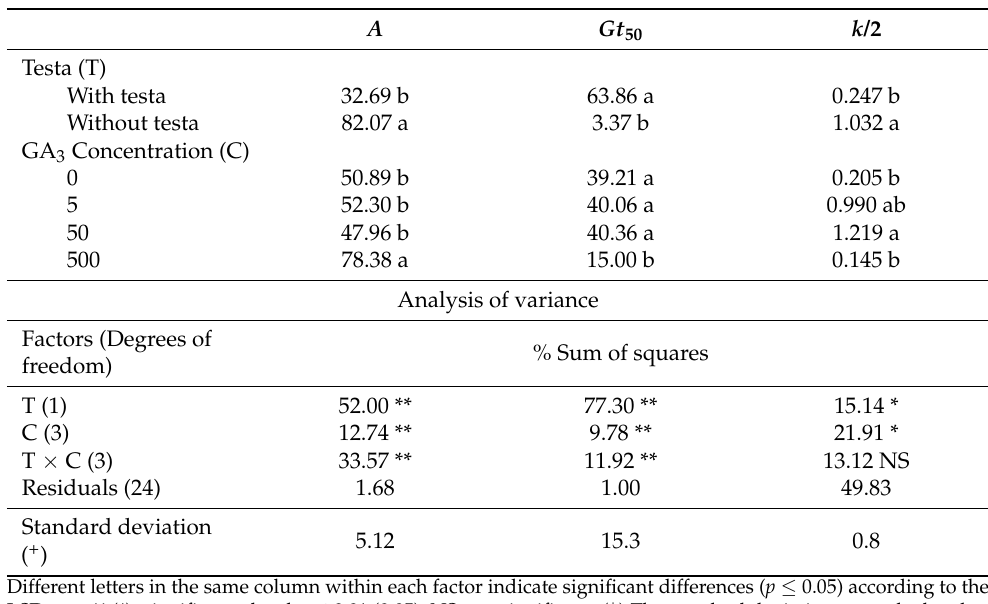
Figure 5. Logistic model adjusted to the germination curves of the seeds with (solid lines) and without testa (dashed lines) with substrate wetted with different GA 3 concentration solutions (0, 5, 50 and 500 mg L − 1 in red, orange, yellow and brown, respectively). Average values of four replicates. Table 2. Effect of the presence of the testa and the concentration of the GA 3 solution used to wet the substrate (0, 5, 50 and 500 mg L − 1 ) on the final germination ( A , %), the number of days needed to reach 50% of the final germination ( Gt 50 , d) and the relative average rate of accumulated germination ( k /2, d − 1 ). Average values of four replicates.